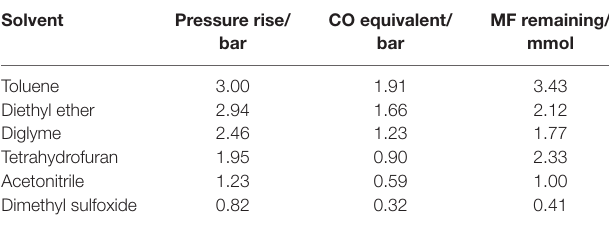
cO equivalent/ MF remaining/ bar bar mmol